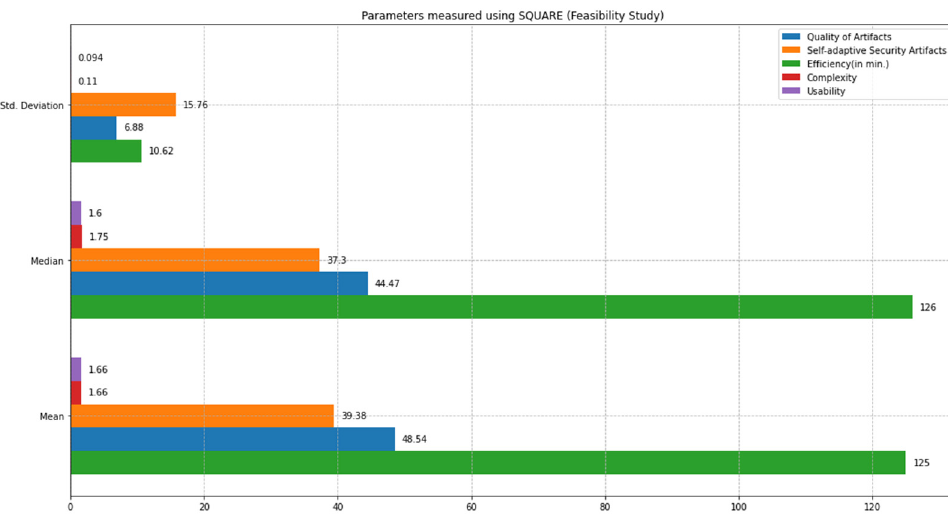
Figure 12. Statistical test for parameters measured using SQUARE approach for feasibility study .